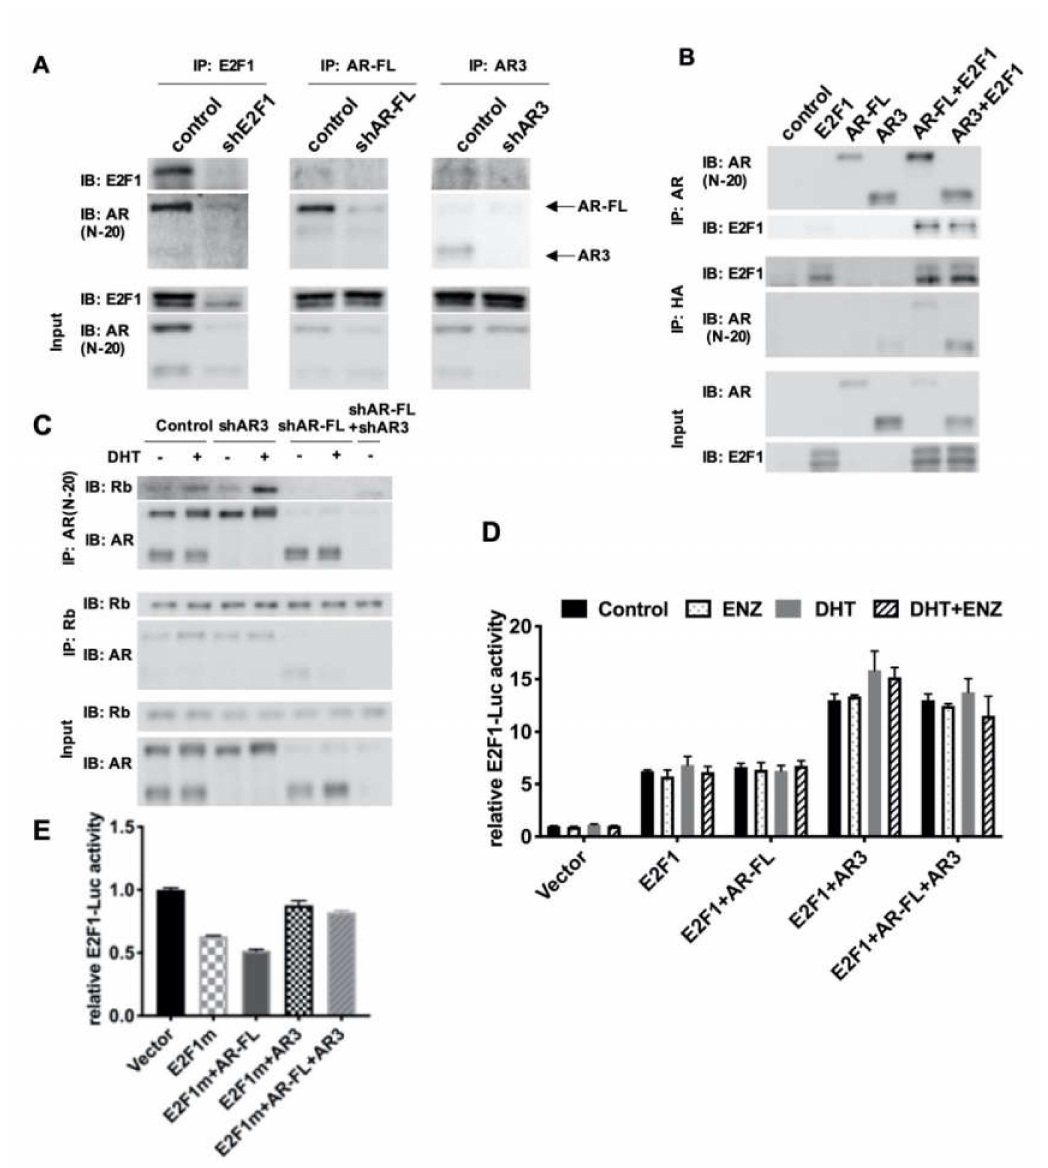
Figure 4. AR3 and AR-FL recruited di ff erent cofactors and di ff erentially regulated E2F1 gene expression. ( A ) R1-ADR cells were infected with the lentivirus encoding the control shRNA, shAR3 or shAR-FL for 48 h. Cell lysates were then immunoprecipitated with an anti-AR or anti-E2F1 antibody followed by western blot. ( B ) HEK293T cells were cotransfected with AR-FL, AR3, and / or E2F1-HA. Cell lysates were then immunoprecipitated with an anti-AR or anti-HA antibody followed by western blot. ( C ) R1-ADR cells were infected with the lentivirus encoding the control shRNA or shAR3 or shAR-FL for 48 h and then treated with 10nM DHT for 2 h before collection. Cell lysates were then immunoprecipitated with an anti-AR or anti-Rb antibody followed by western blot. ( D ) E2F1-promoter luciferase assay was performed in HEK293T cells treated with 0.1nM DHT or / and 10 µ M ENZ. ( E ) E2F1-promoter luciferase assays with mutant E2F1 were performed in HEK293T